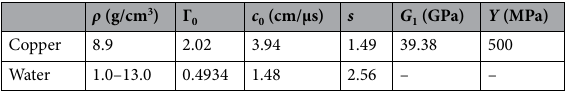
Table 1. Parameters in simulations for solid and fluid 42–44 .